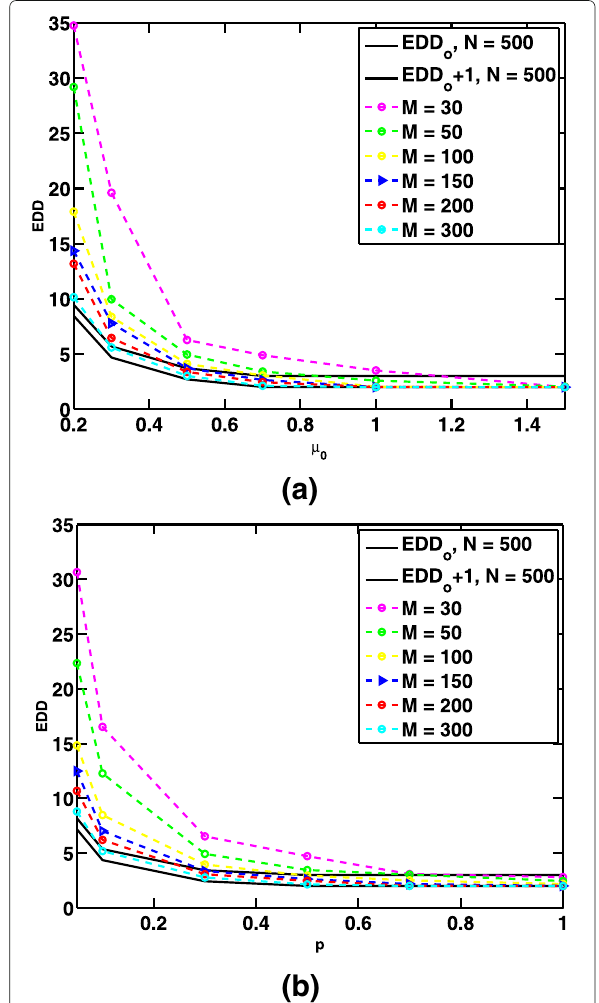
Fig. 5 A being a fixed Gaussian random matrix: the standard deviation of each point is less than half of its value. a EDD versus μ 0 , when all [ μ ] i = μ 0 ; b EDD versus p when we randomly select 100 p % entries [ μ ] i to be 1 and set the other entries to be 0; the smallest value of p is